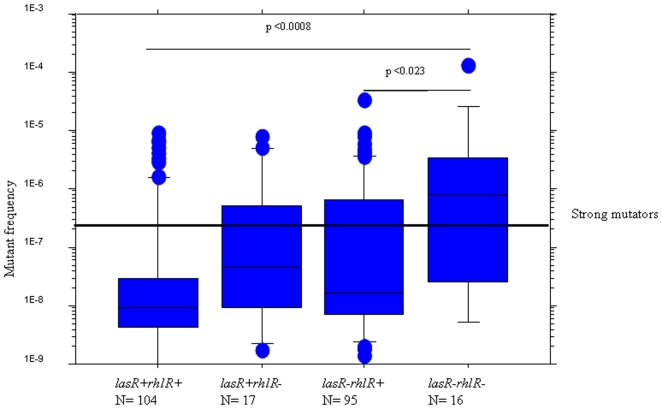
Association between occurrence of mutations in the QS genes and the mutability of the isolates.Box and whisker plots represent the median (thick line inside the box), 10, 25, 75 and 90 centiles of the mutation frequency measured by the occurrence of spontaneous antibiotic resistance in isolates with mutations in both QS regulatory genes (lasR−rhlR−), only in one of the regulatory genes (lasR−rhlR+) or (lasR+rhlR−) or without mutations in either of the regulatory genes (lasR+rhlR+). Mann-Whitney test was used to investigate the significance of the differences between the groups.